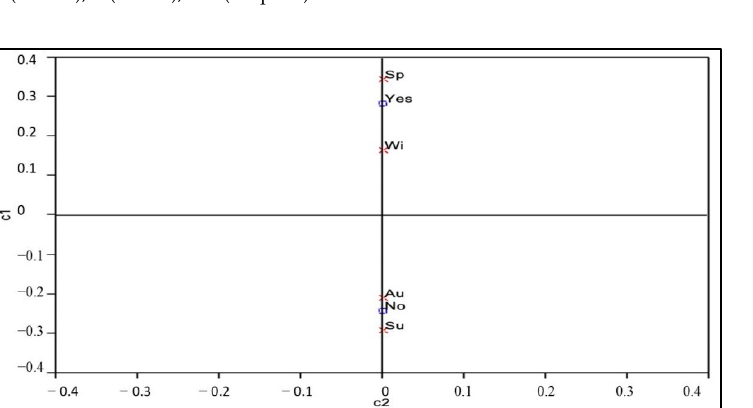
Figure 1. Correspondence analysis of the distribution of flowering honey bee plants across the different seasons. × = Seasons; = Flowering status; Sp = Spring; Wi = Winter; Au = Autumn; Su = Summer. The category “Yes” is quite near to “Winter” and “Spring” while “No” is related to “Autumn” and “Summer”, implying that flowering honey bee plants occur more during winter and spring and less in summer and autumn.